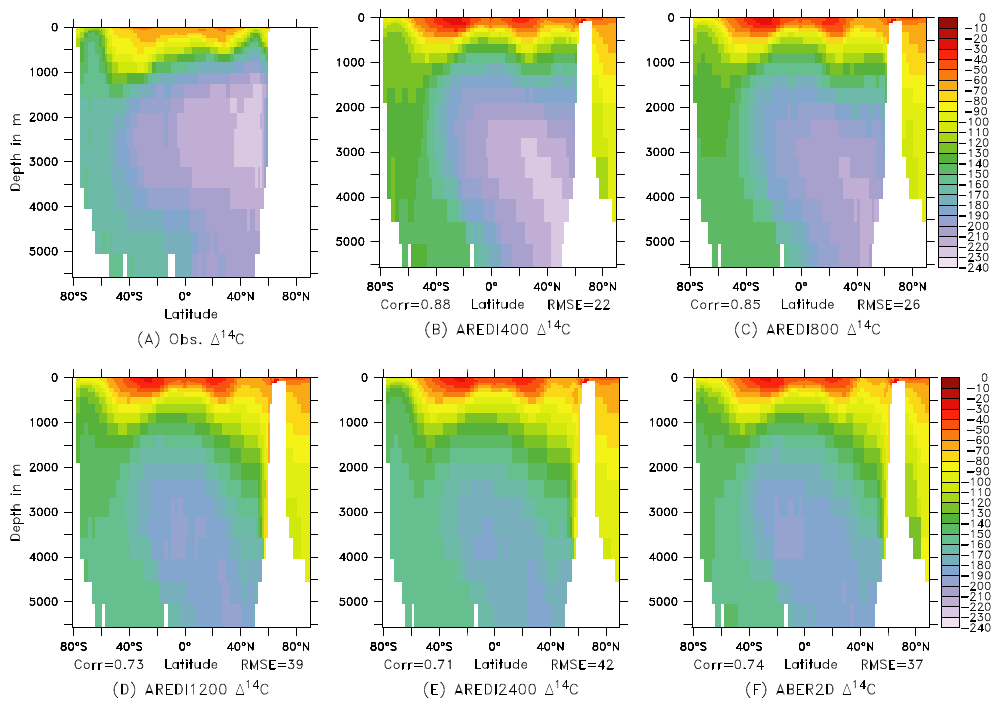
Figure 5. Zonally averaged (cid:49) 14 C (in ‰) in the Pacific. (a) From the observational data set of Key et al. (2004). (b) AREDI400.